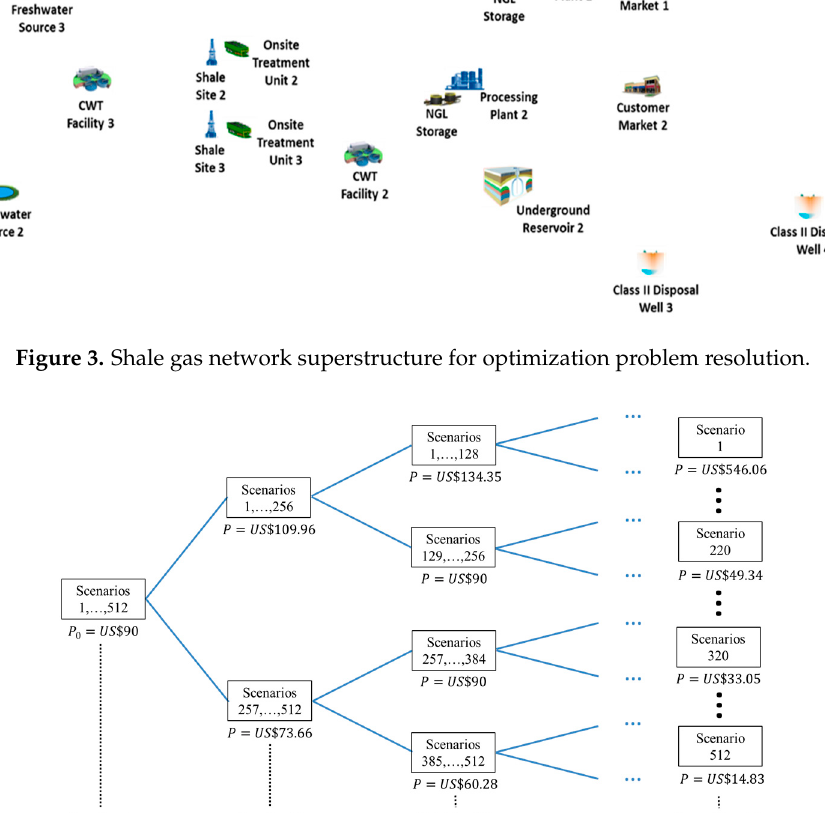
Figure 3. Shale gas network superstructure for optimization problem resolution.